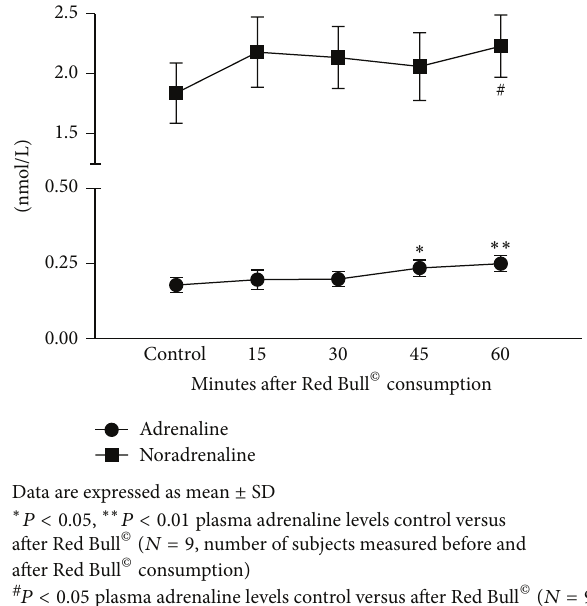
Figure 1: Influence of Red Bull © on plasma adrenaline and nora- drenalin